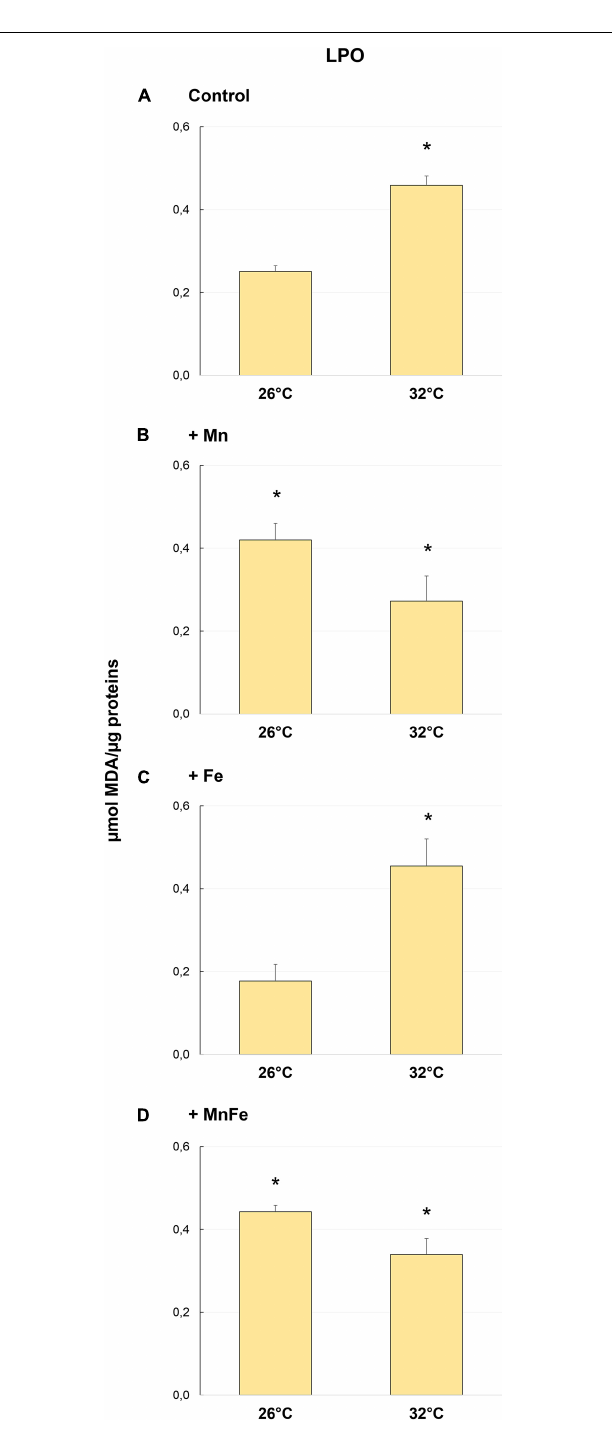
FIGURE 3 | Levels of lipid peroxidation (LPO) detected in samples of S. pistillata exposed to the different metal treatments ( A : Control; B : +Mn; C : +Fe; D : +MnFe) after 6 weeks at 26 ◦ C or 3 weeks at 32 ◦ C. The values related to the metal concentrations for each treatment are reported in section “Materials and Methods.” Data are expressed as µ mol of MDA per µ g of proteins and as mean ± SEM ( n = 4). Asterisks indicate significant differences between corals maintained at 26 and 32 ◦ C under different treatments and, within each treatment, between corals maintained at 26 and 32 ◦